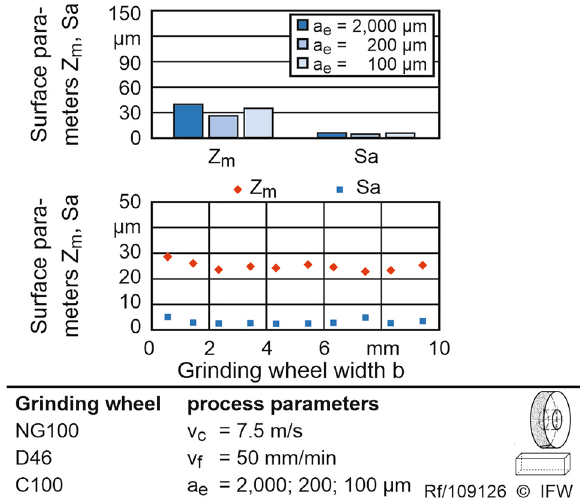
and Sa of reference grinding m